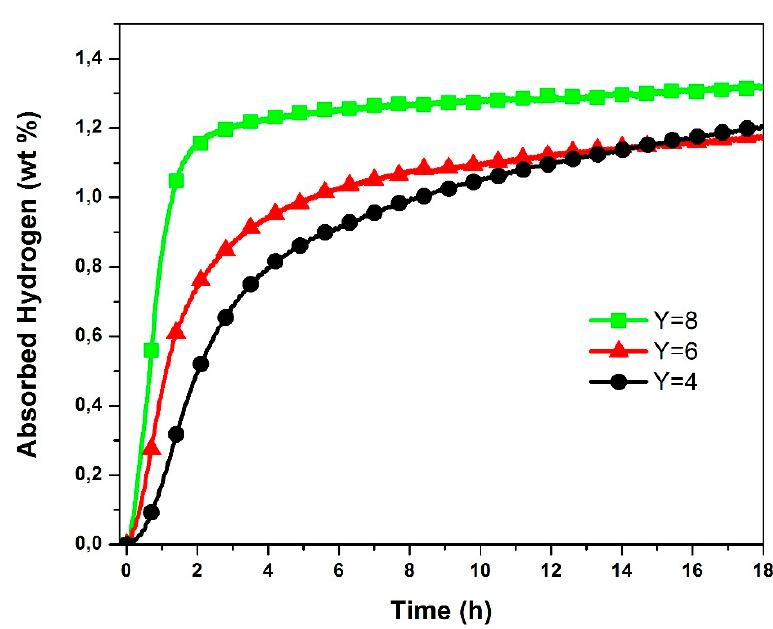
Figure 5. First kinetics hydrogenation at room temperature and at a pressure of 2500 kPa of hydrogen TiFe alloys + x wt.% Y for x = 4, 6, and 8.